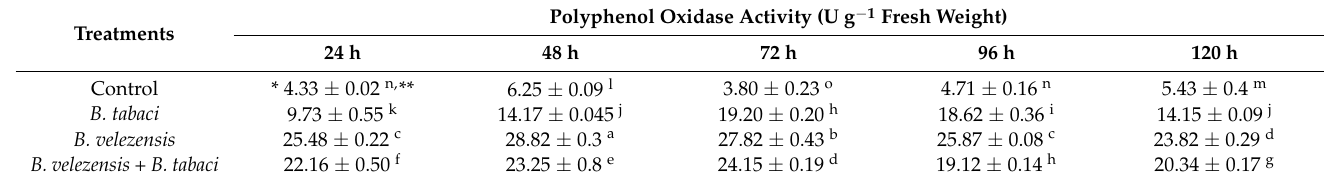
Table 3. The time-course of polyphenol oxidase activity in squash plants exposed to Bemisia tabaci and Bacillus velezensis, and both agents compared with